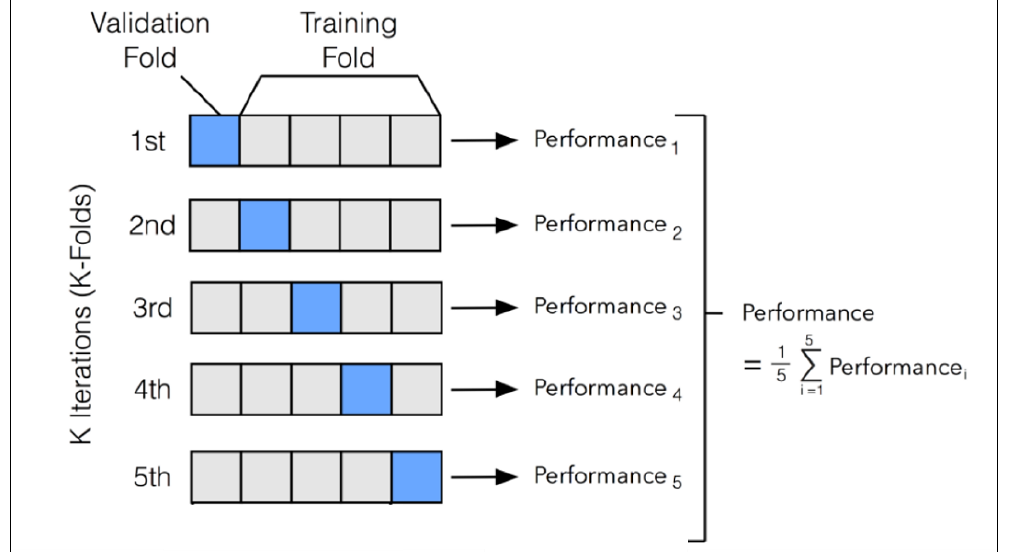
Figure 14. 5-Fold Cross Validation